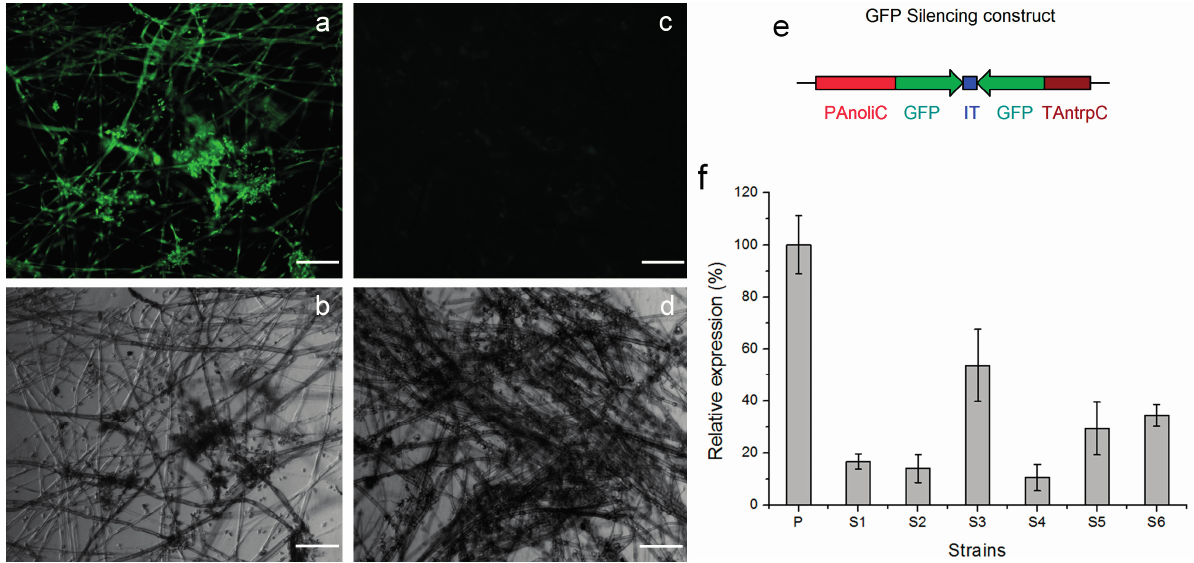
Figure 4. The silencing vector pCBSilent1-eGFP induced GFP silencing in B. cinerea with high efficiency. GFP fluorescence and bright field images of the mature hyphae of a